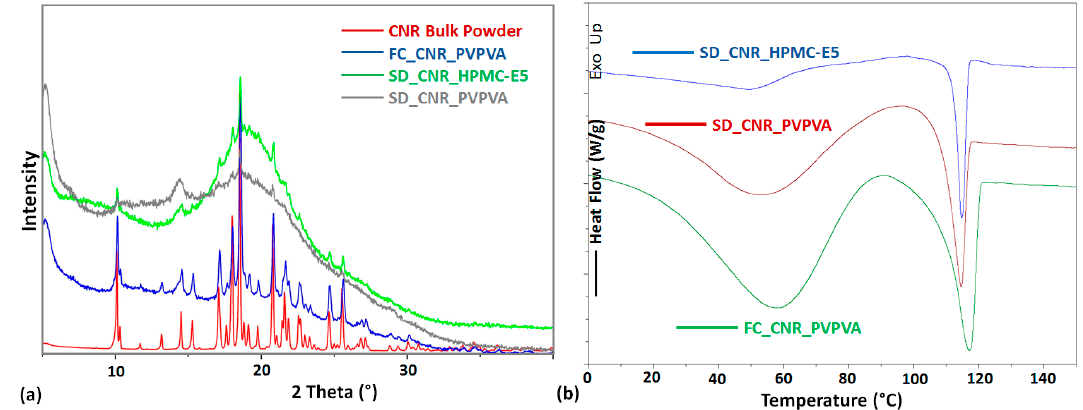
Figure 2. ( a ) Comparison PXRD patterns of bulk Cinnarizine with its ASD samples with PVPVA 64 and HPMC-E5. ( b ) Overlays of mDSC thermograms of ASDs of Cinnarizine, prepared by film casting and spray drying.